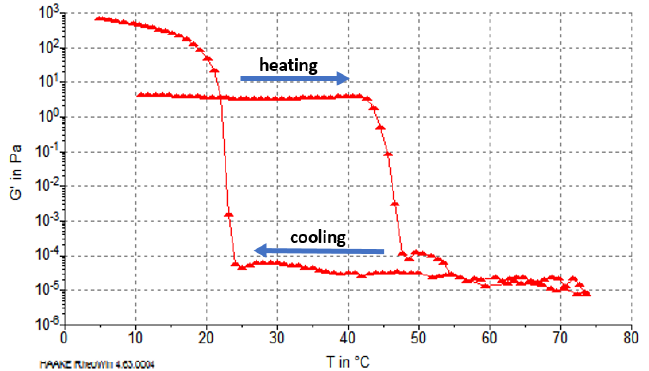
Figure 4 . Changes in the G ’ value of atelocollagen fibers (from cartilage after pretreatment with MgCl 2 ).